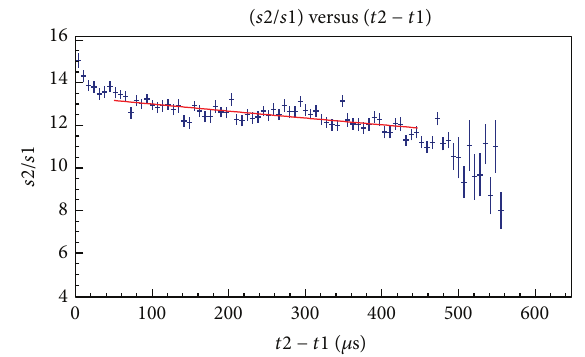
Figure 8: 𝑠2 / 𝑠1 ratio as a function of drift time ( 𝑡2 − 𝑡1 ). The region used for an exponential fit (red line) allows estimating the electron life time. The decrease of the 𝑠2 / 𝑠1 value for the highest drift times is related to few badly reconstructed events near the